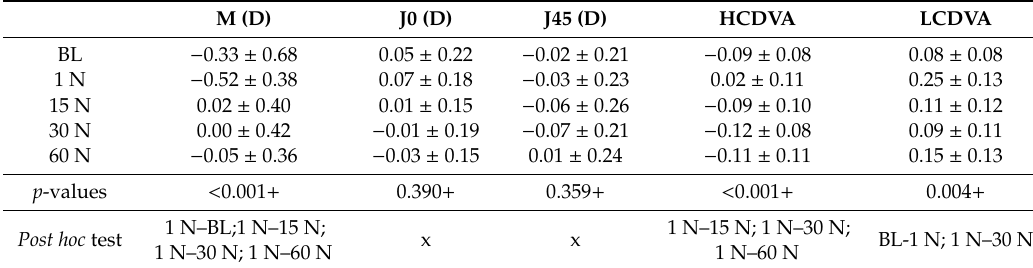
Table 1. Objective spherical equivalent central refraction or M (D; mean ± SD), astigmatic power vectors at 0 ◦ and 45 ◦ and distance VA under high-contrast distance visual acuity (HCDVA) and low-contrast distance visual acuity (LCDVA) (LogMAR units; mean ± SD) at baseline (BL) and after 1, 15, 30, and 60 nights of orthokeratology (OK) lens wear.